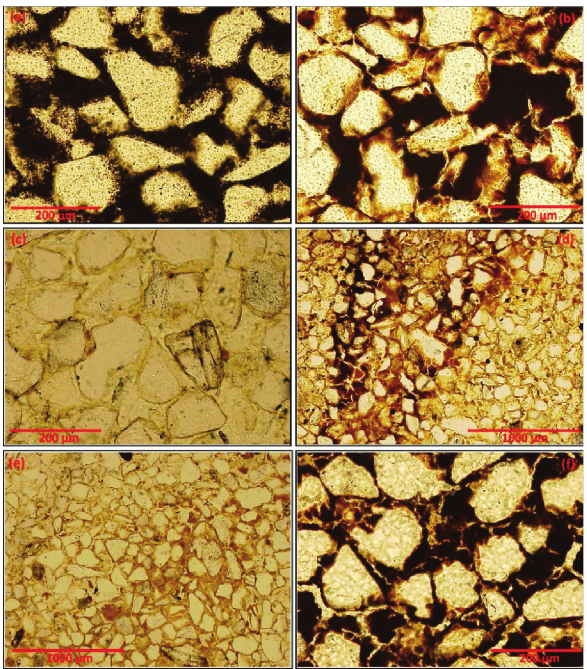
Figura 2. Fotomicrografias mostrando: (a) horizonte Bh1 (perfil P3) com matéria orgânica exclusivamente monomórfica preenchendo totalmente a porosidade (distribuição relativa g/f 2µm porfírica); (b) fábrica característica do horizonte Bhm1 (perfil P3); distribuição relativa g/f 2µm complexa. Notar desenvolvimento de porosidade cavitária policôncava, sendo formada pela decomposição do material fino que outrora preenchia totalmente a porosidade. Notar bordas mais claras, dégradé de cores e finos, com sua separação em unidades